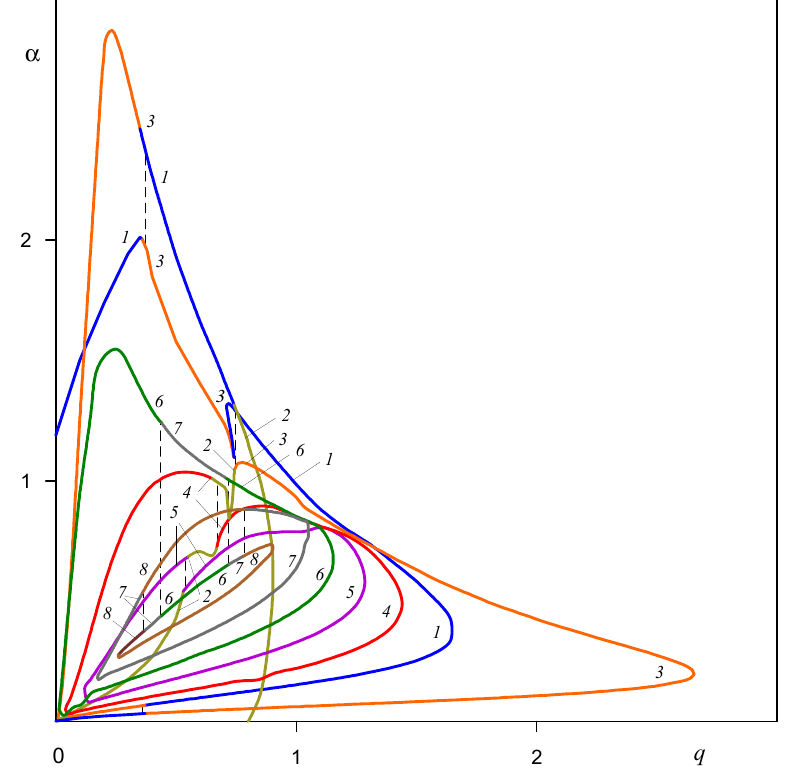
Figure 6. Neutral curves for Re = 5000; modes 1–8 (curves 1–8). The dashed lines correspond to the q values at the branch points. Mode 3 is unstable at a much larger swirl of the flow compared to the known value q = 1.5 for mode